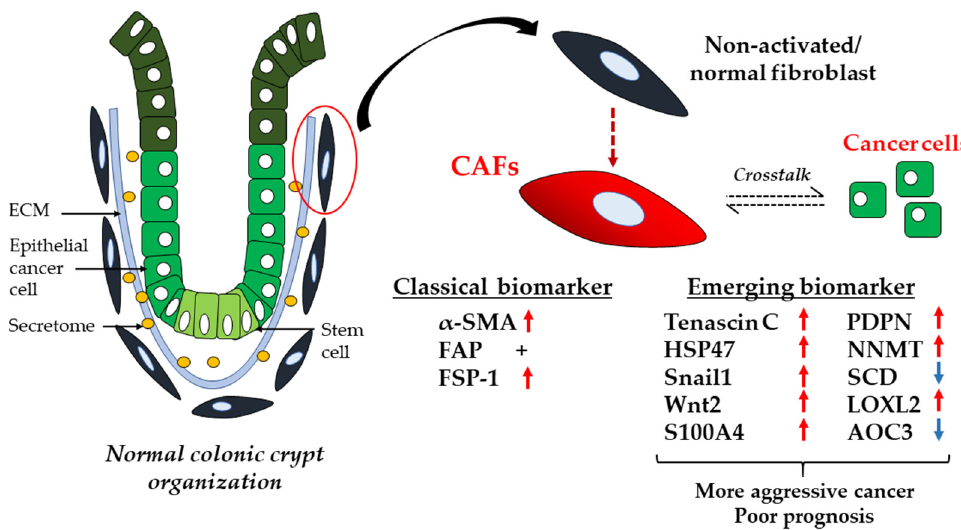
Figure 2. Conventional and emerging CAF markers. CAF transdifferentiation from normal fibroblast (represented by the red circle) and activation are influenced by crosstalk with epithelial cancer cells in the colon. CAFs can be represented by various markers. Classical markers have been applied extensively for CAF characterisation despite their heterogeneous expression. Emerging CAF markers can be potentially used in combination with conventional markers to further dissect the molecular properties of CAFs and to determine prognosis of patients. HSP47: heat shock protein 47; Snail1: Snail family transcriptional repressor 1; Wnt2: Wnt family member 2; S100A4: S100 calcium-binding protein A4; PDPN: podoplanin; NNMT: nicotinamide N-methyltransferase; SCD: stearoyl-CoA desaturase; LOXL2: lysyl oxidase-like 2; AOC3: amine oxidase copper-containing 3; +: positive expression; blue downwards arrow: downregulation of expression; red upwards arrow: upregulation of expression.